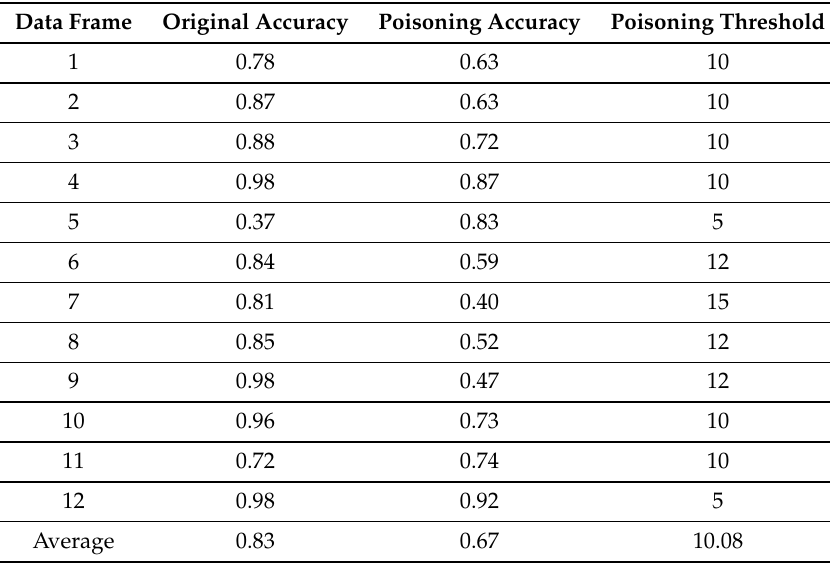
Table 2. Results of Dynamic New Entries